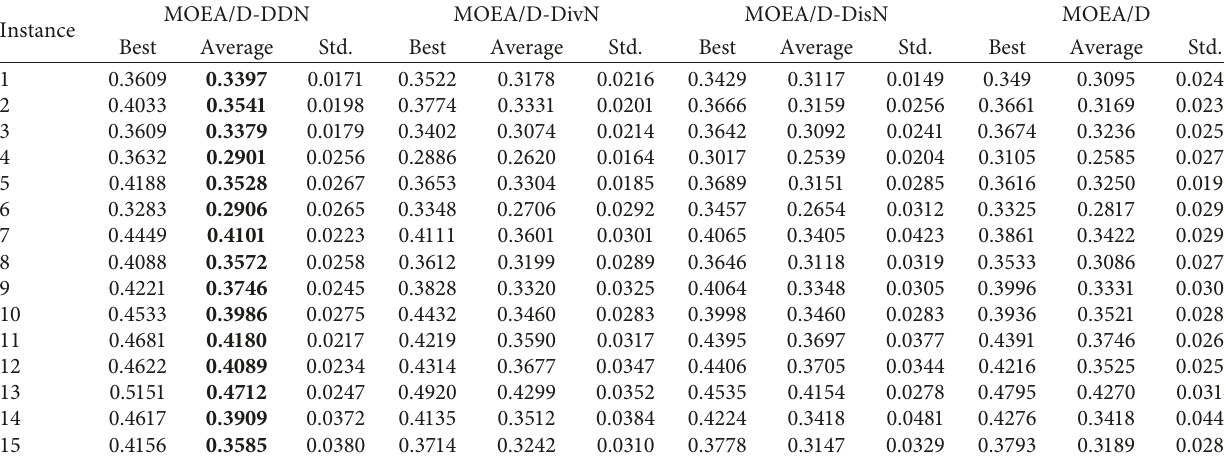
Table 3: Performance (hypervolumn) comparison of MOEA/D-DDN, MOEA/D-DivN, MOEA/D-DisN, and